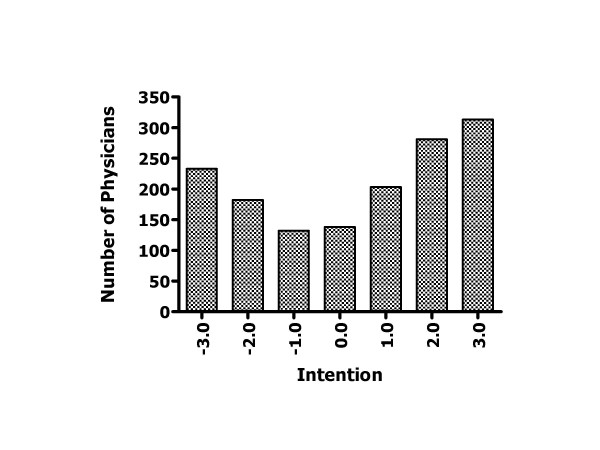
Distribution of the intention to prescribe HT.